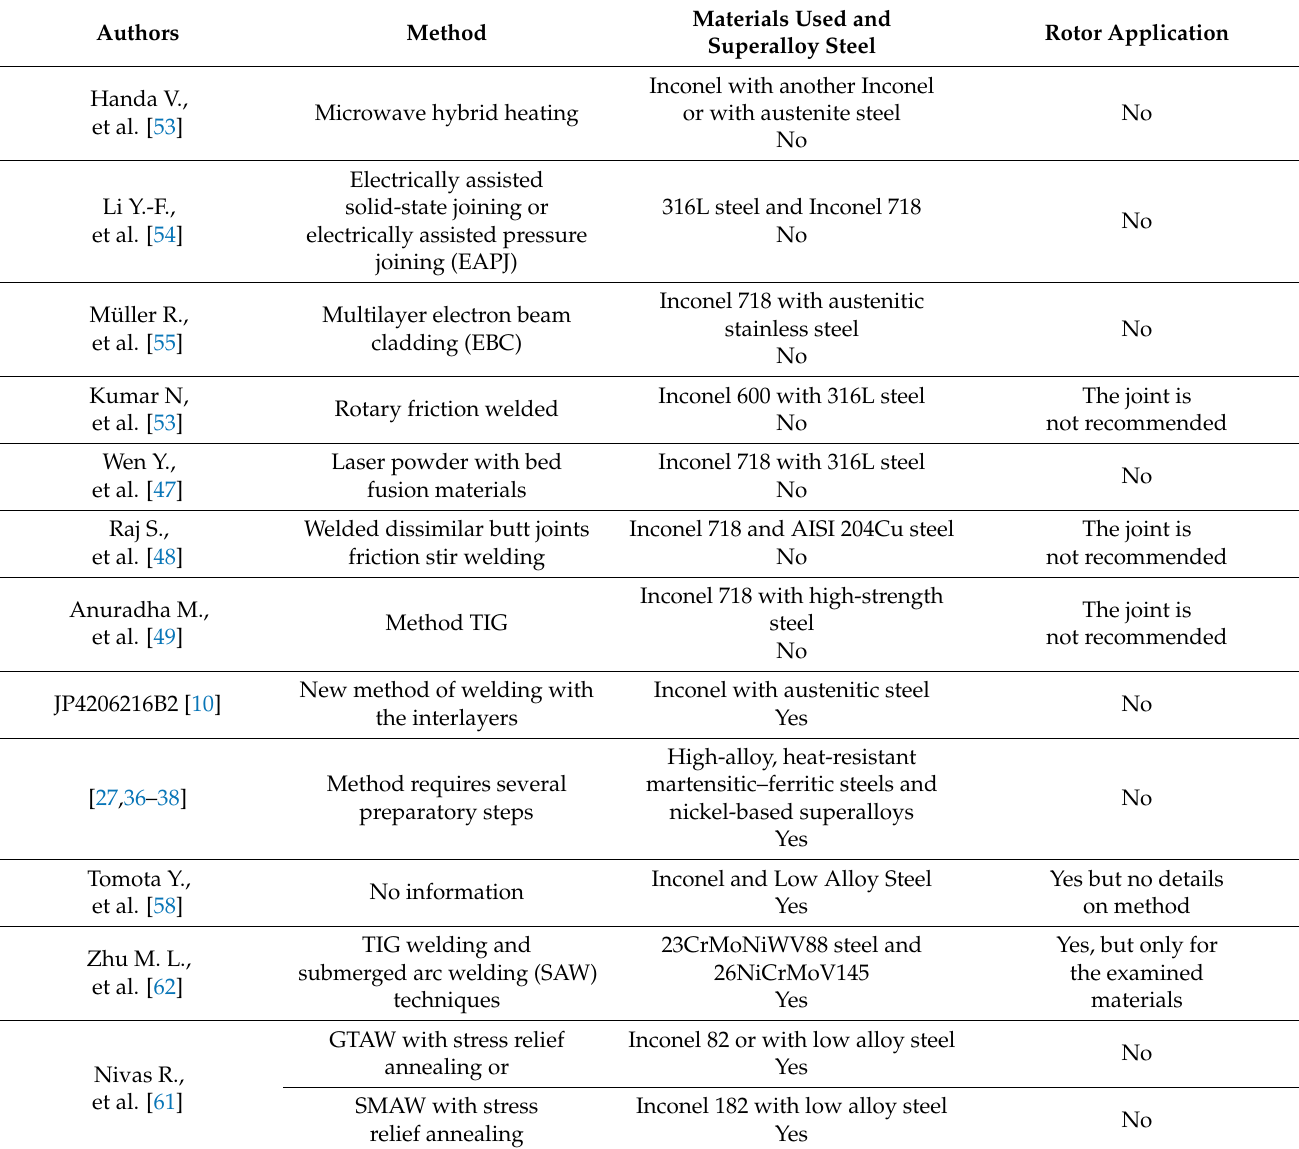
Table 1. Methods, materials and final welding joint concerning superalloy and alloy steel at rotor